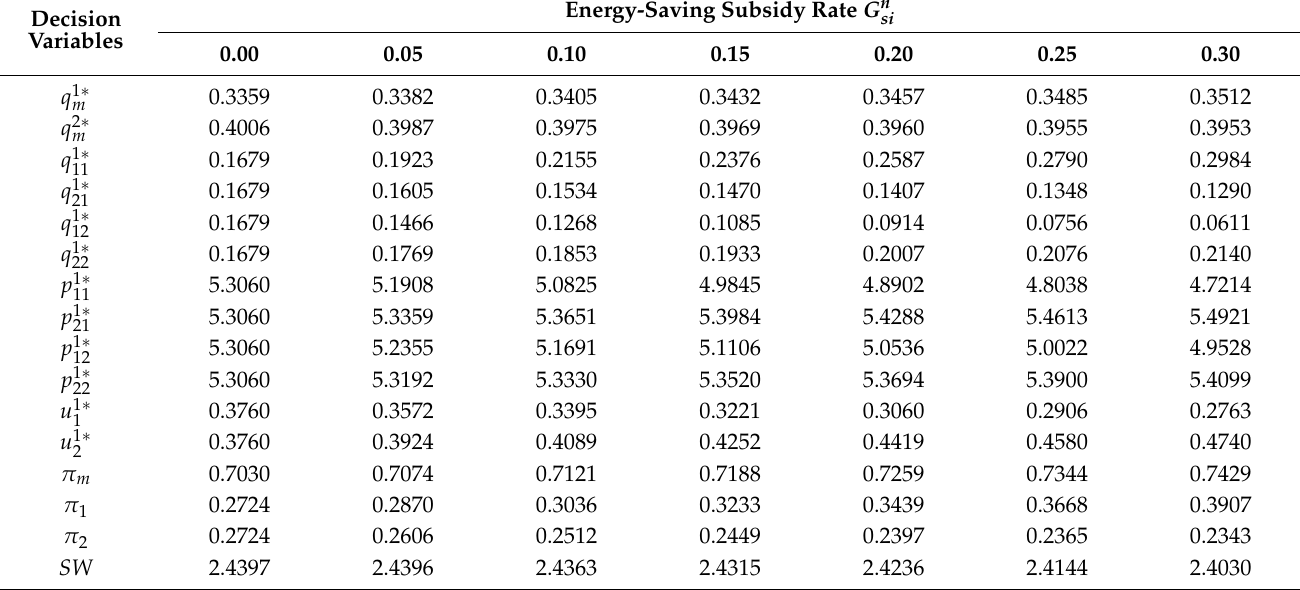
Table A4. The equilibrium result of government only subsidies to retailer 1 in market 1 when demand scales of HEEP and LEEP is